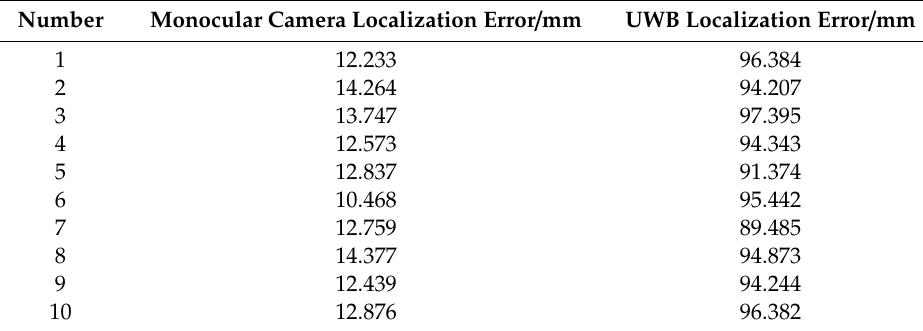
Figure 11. The localization result of UWB and monocular camera: ( a ) relative to the results of the localization of the entire path; ( b ) localization results relative to a path zoom. Table 3. Average errors of 10 localization results without occlusion.